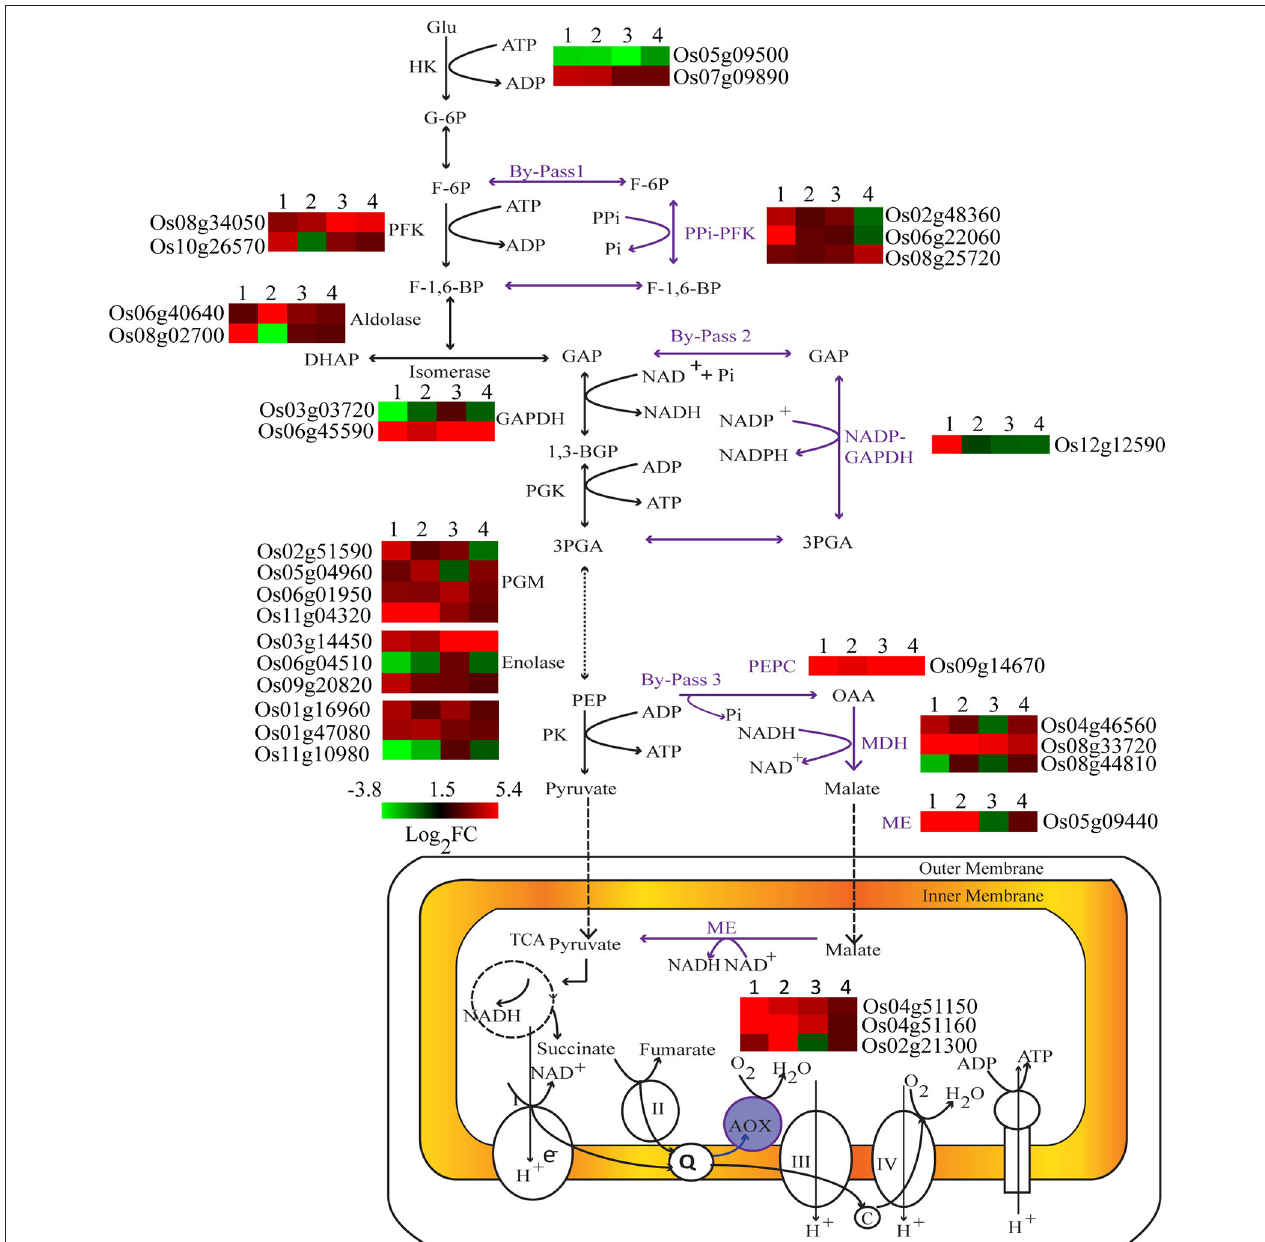
FIGURE 4 | Differential expression of key genes involved in carbohydrate metabolism under Pi deficiency. Expression profiles of differentially expressed genes regulating key metabolic reactions are shown adjacent to their enzyme products. 1, Dular root; 2, PB1 root; 3, Dular shoot; 4, PB1 shoot.